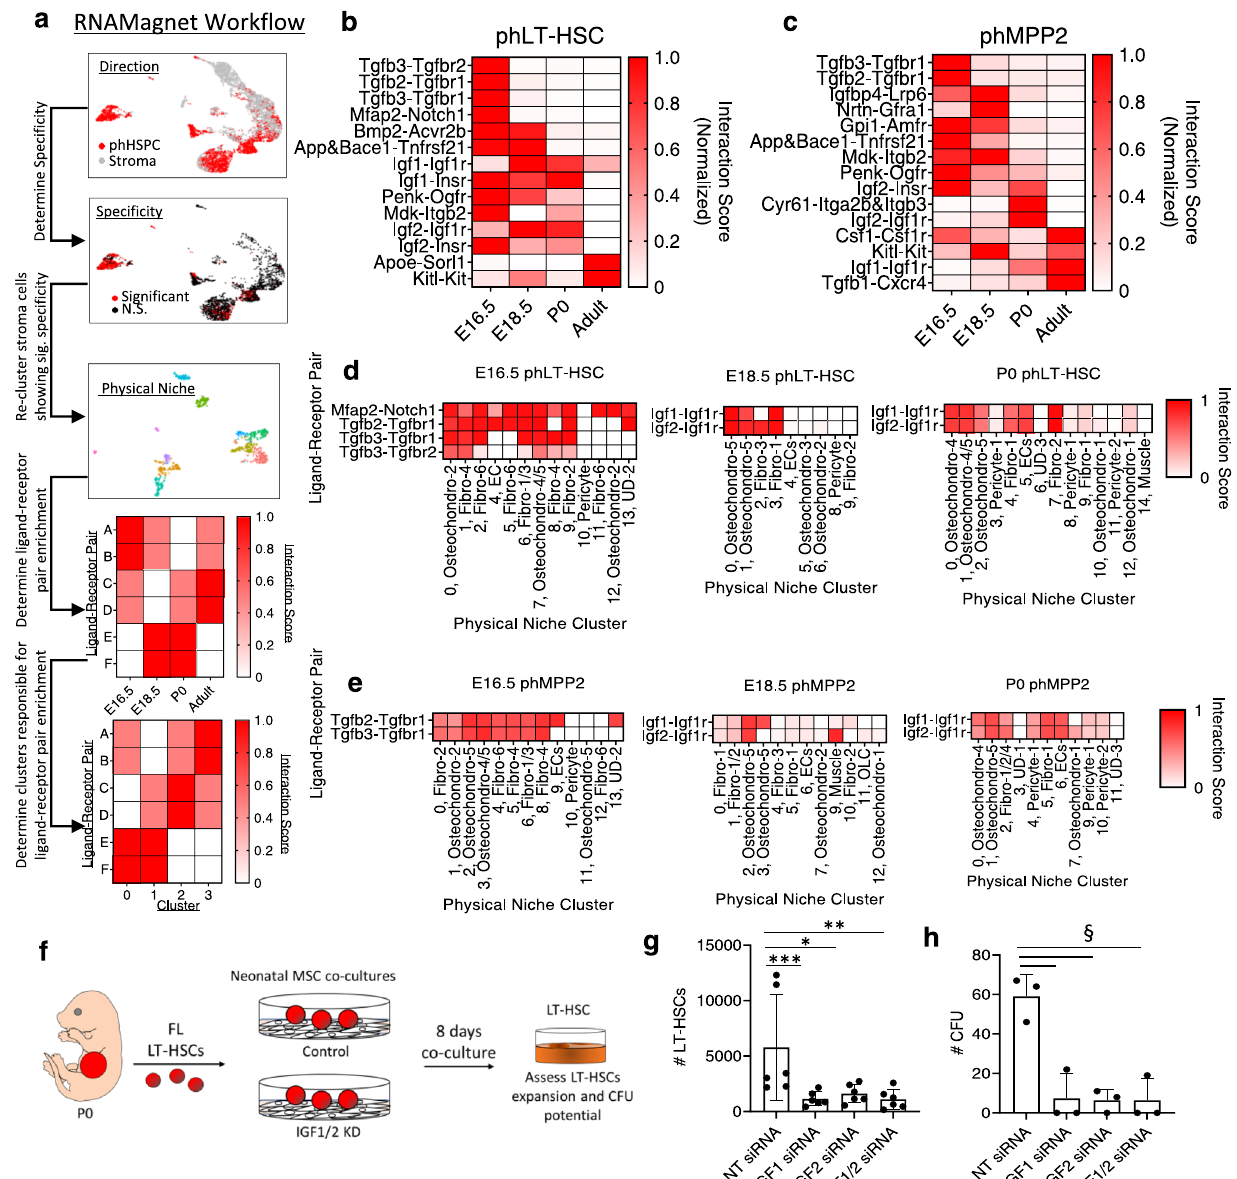
Fig.8|PhysicalnichesandnichefactorsforperinatalBMHSPCs.a RNA-Magnet work fl ow. b Normalized interactionscores of ligand-receptorpairs with signi fi cant interaction(secretedligand from stroma,receptorfrom phLT-HSCs) c Normalized interaction scores of ligand-receptor pairs with signi fi cant interaction (secreted ligand from stroma, receptor from phMPP2s). Interaction scores for each sig- ni fi cant ligand-receptor pair (rows) across development within clusters of the phLT-HSC ( d ) or phMPP2 ( e ) physical niche (columns, with dominant stromal cell type indicated for each physical niche cluster). f Schematic of P0 FL HSCs co- cultureswithIGF1orIGF2siRNA-treatedP0MSCs. g #phLT-HSCsafter8daysofFL LT-HSCs co-culture on control, IGF1, IGF2 or IGF1/2 siRNA-treated P0 MSCs ( n